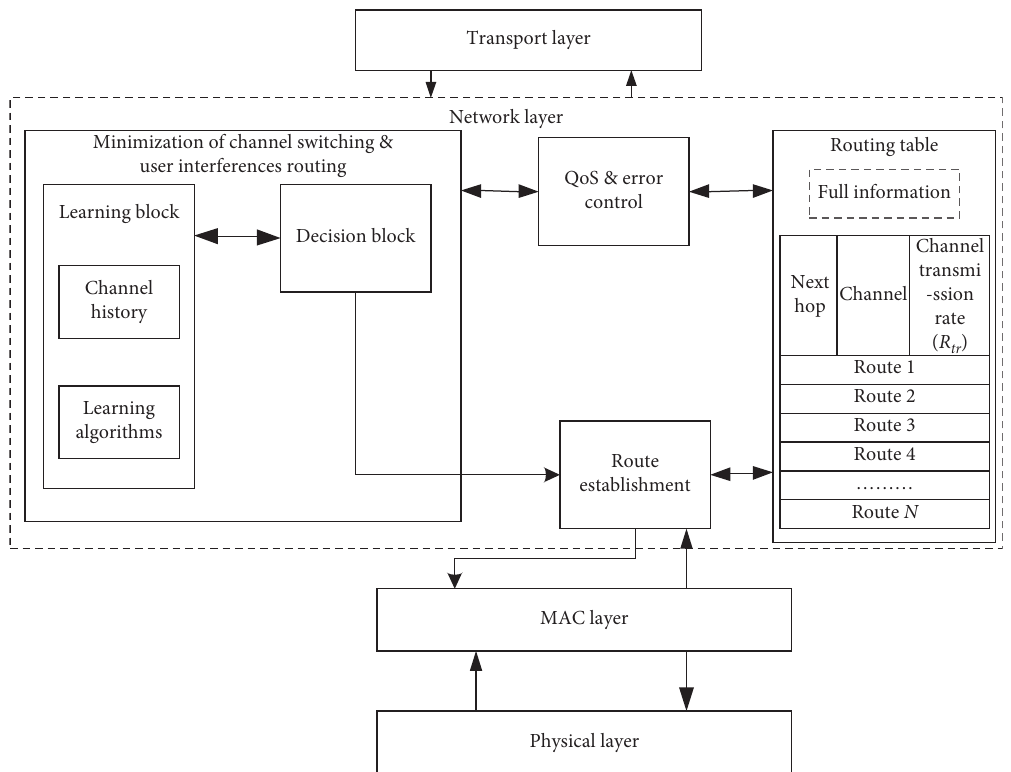
Figure 2: Implementation of MCSUI routing protocol at the network layer.